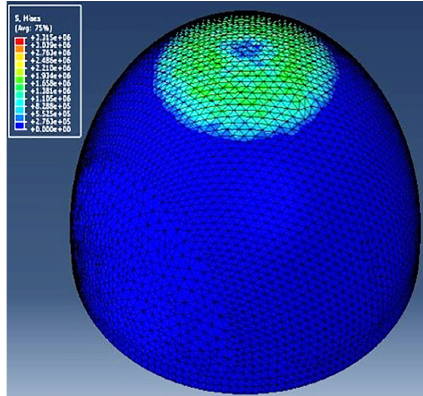
Fig. 23. Von misses composite stress contour contour in spherical building while explosion strikes building in 10 meters high from the roof